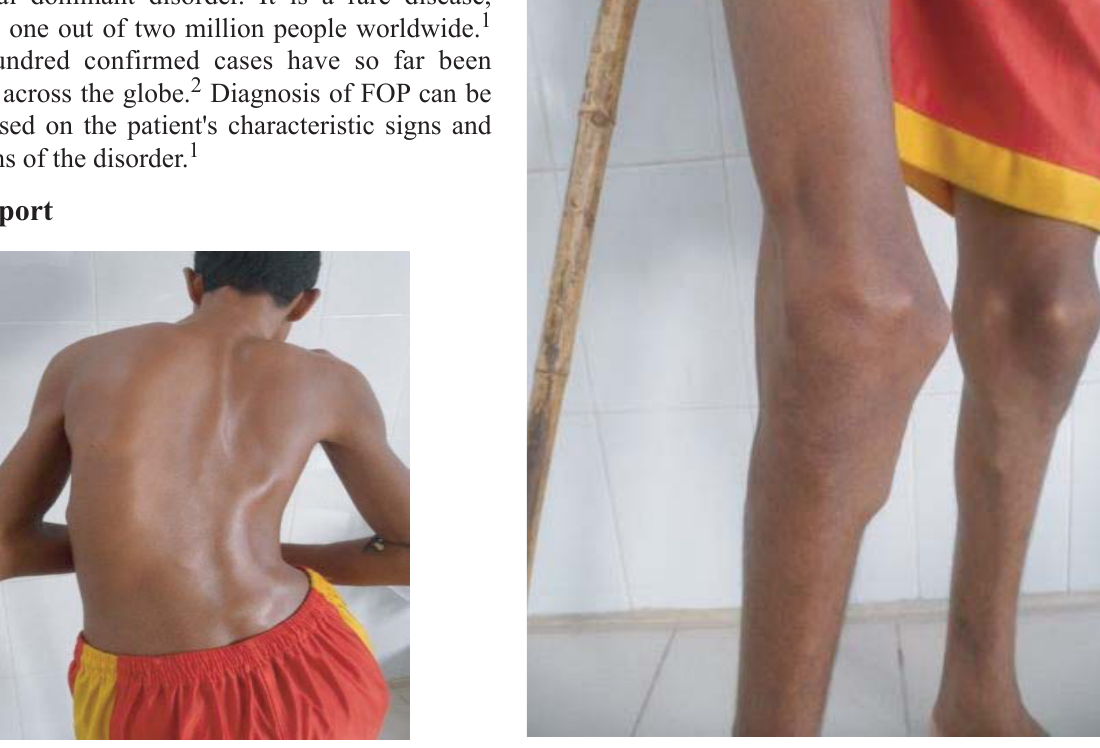
Fig 1. Scoliosis and bony exostosis in paravertebral region Fig 2. Bony exostosis around both knee